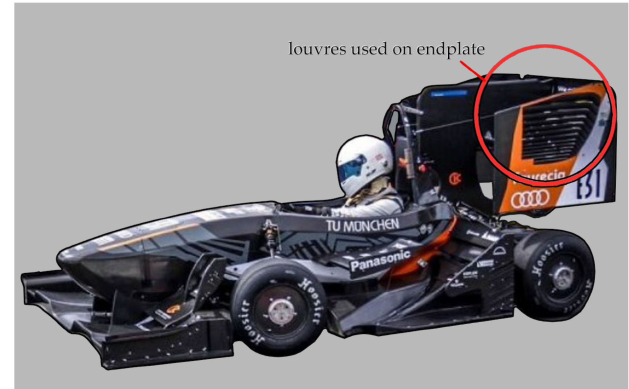
Figure 2. Louvres used on the